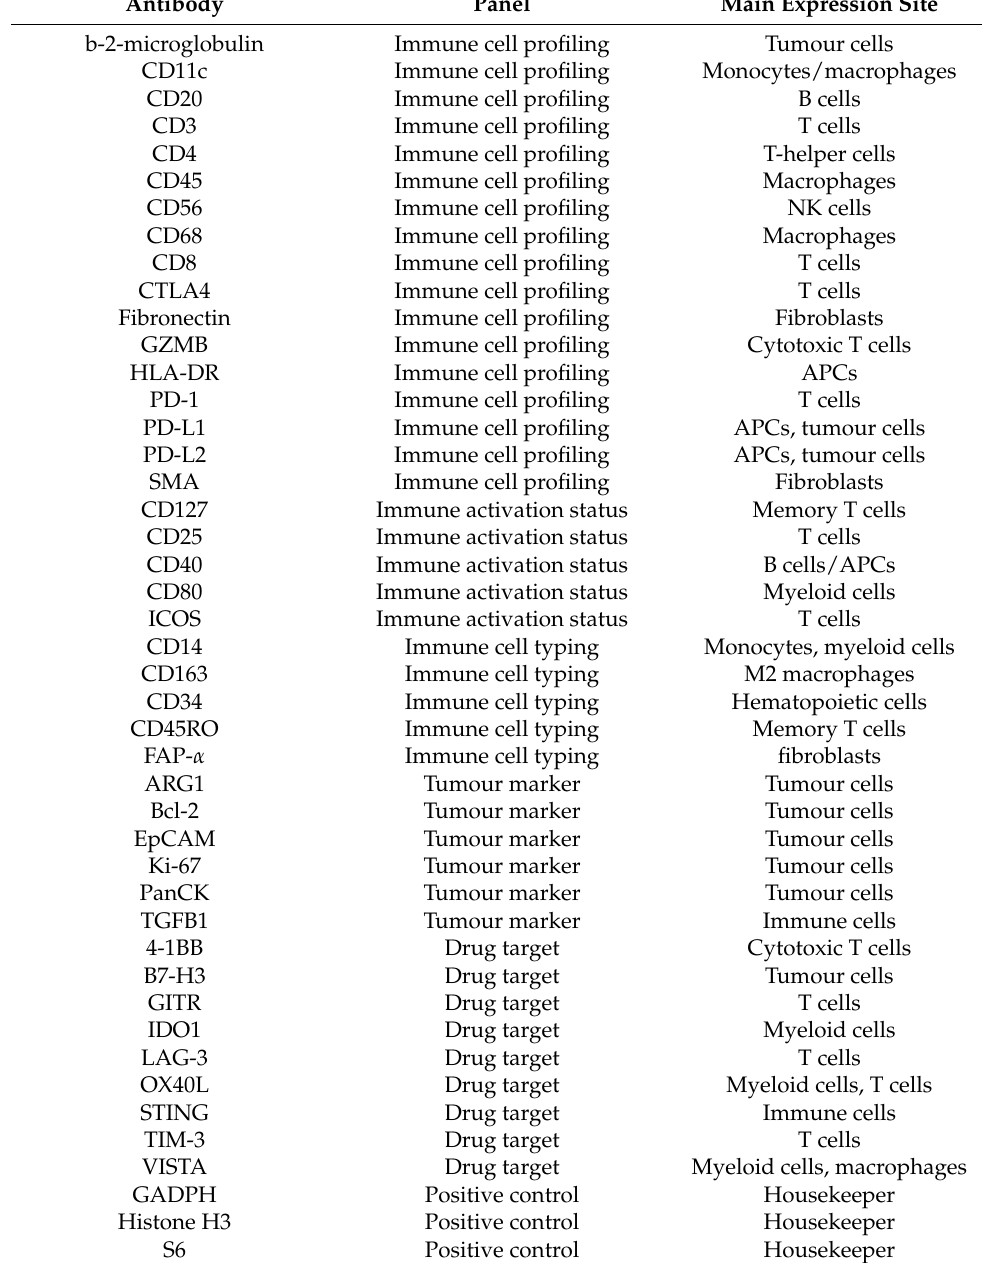
Table A4. Antibodies used in the GeoMx ® DSP